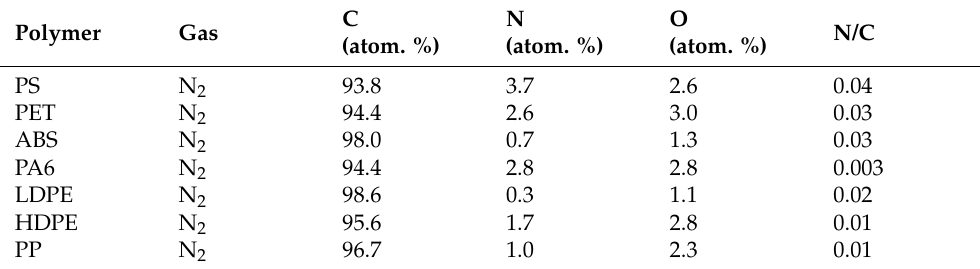
Table 3. XPS surface composition of the deposits synthesized in nitrogen plasma using various polymer sources.